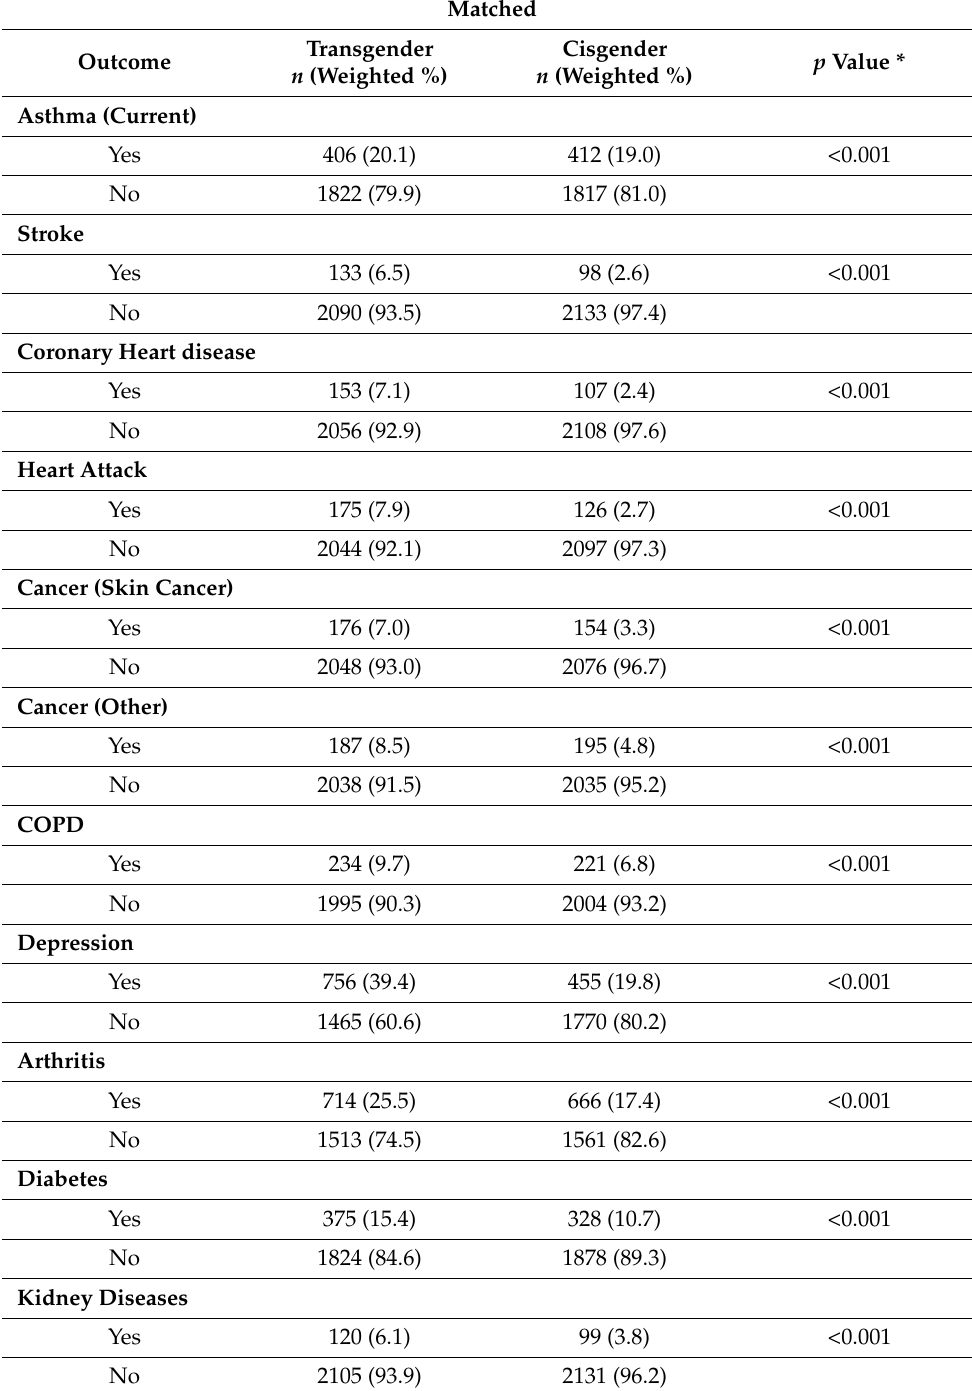
Table 4. Outcome analysis in matched